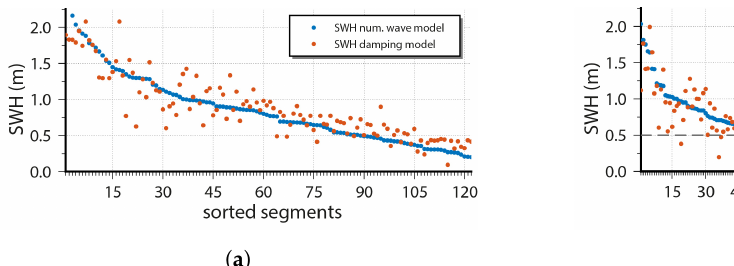
Figure 8. Analyzed ship segments in deep water and shallow water sorted by reference SWH. Reference SWH from the wave model (blue). Estimated SWH from the averaged damping coefficients δ (red). ( a ) Analyzed segments with a water depth of more than 25m. ( b ) Analyzed segments with a water depth of less than